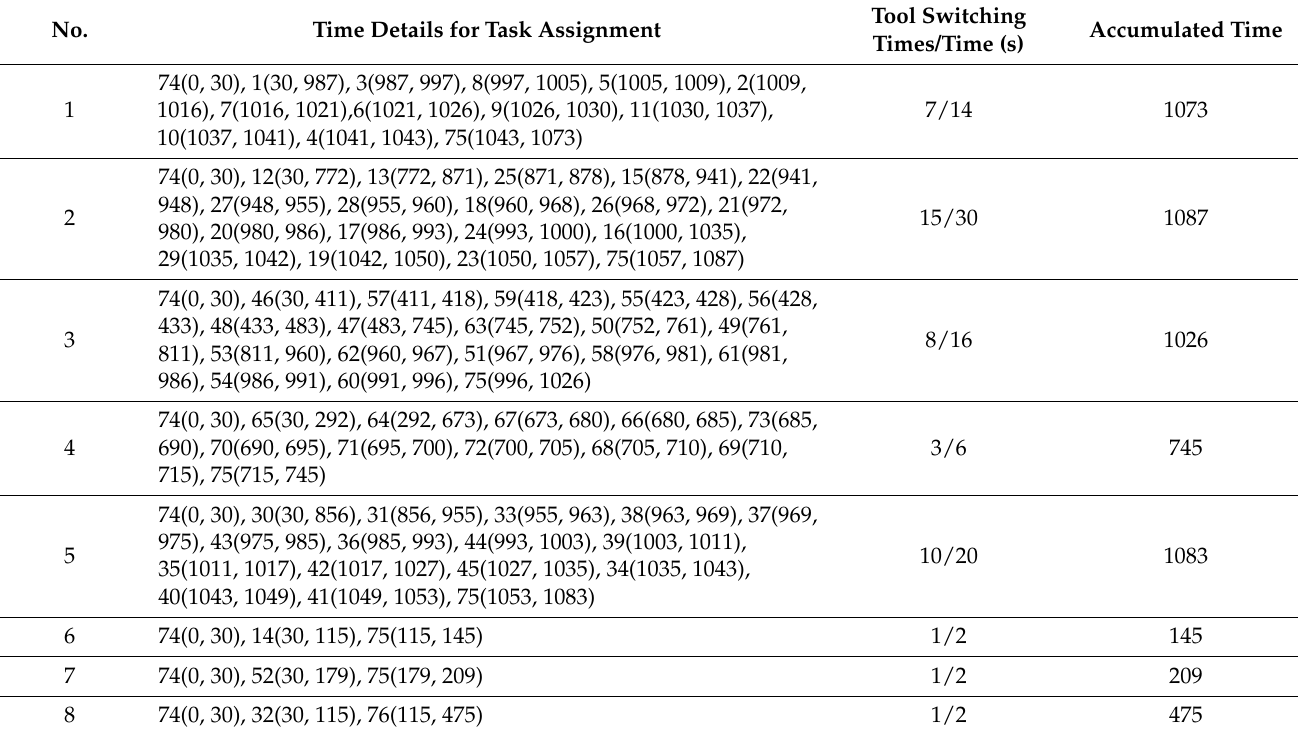
Table 4. Optimization results of ant colony optimization beat 1150 s